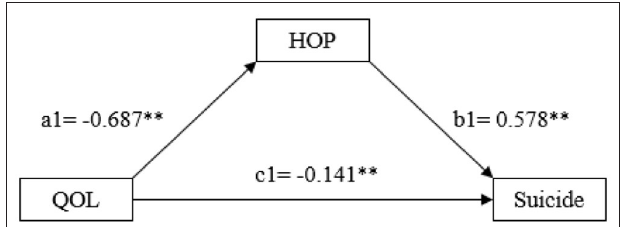
FIGURE 2 | Schematic model of hopelessness as the mediator in the relationship between quality of life and suicide. QOL, quality of life, and HOP, hopelessness. Model coefficients were estimated using the SAS Macro PROCESS (see text for detail); *: p < 0.05, and **: p < 0.01.